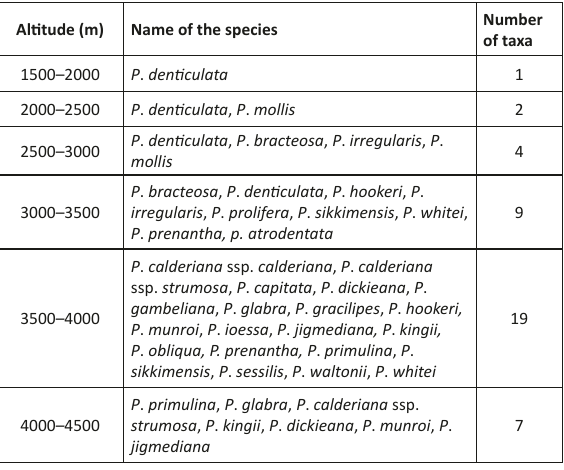
Table 4. Ecological attributes of Primula communities at the study sites.